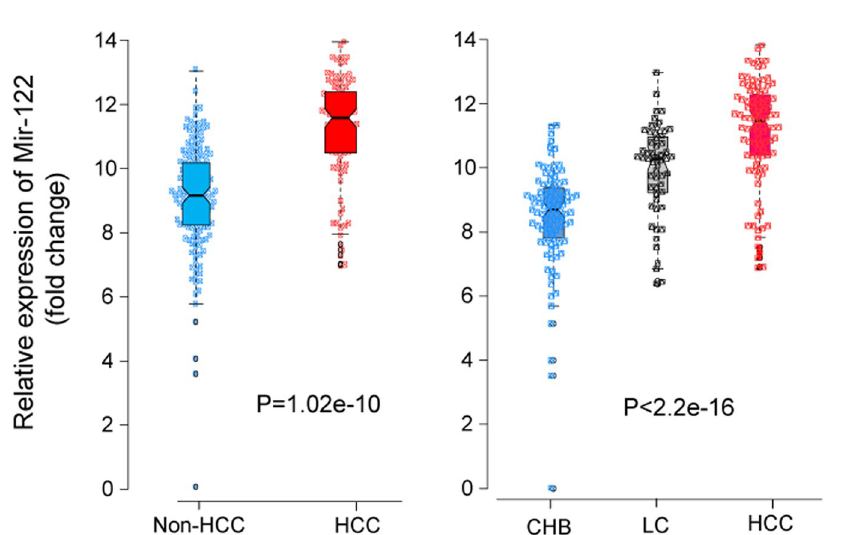
Figure 1. Relative expression of miR-122 in HBV patients. Differential expression of miR-122 in different groups of HBV related liver diseases including hepatocellular carcinoma (HCC), liver cirrhosis (LC), chronic hepatitis B (CHB). P values were calculated by Wilcoxon or Kruskal-Wallis